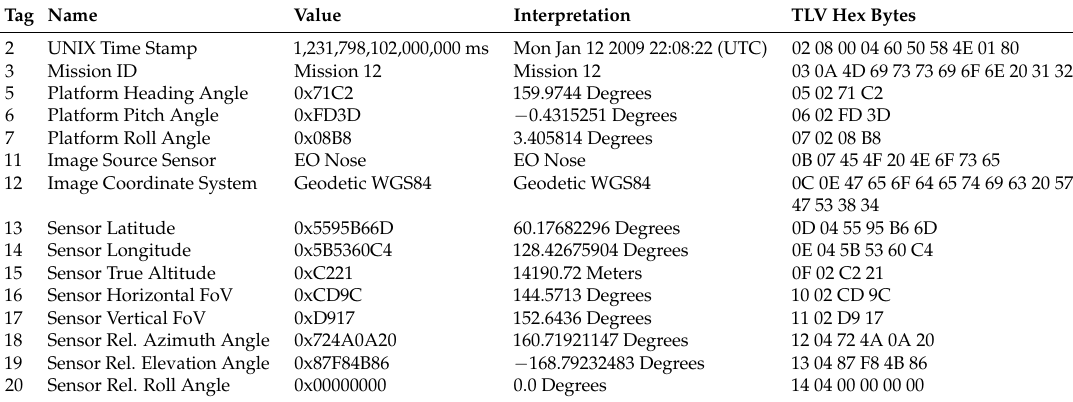
Figure 3. Example of a metadata Key-Length-Value (KLV) packet. It is formed by a key (in green), the length of the whole packet (in purple), and a sequence of metadata. Each metadata is identified by a tag (in cyan), the length of the data (in magenta) and the information itself (in orange). Grid patterned colors have the same meaning as the solid colors [15]. Table 1. Example of Tag-Length-Value (TLV) packets contained in a Key-Length-Value (KLV) packet. The table shows: the TLV hexadecimal value (last column), the tag (first column) of the metadata (second column) and its value (third column), and the interpretation of the specific value (fourth